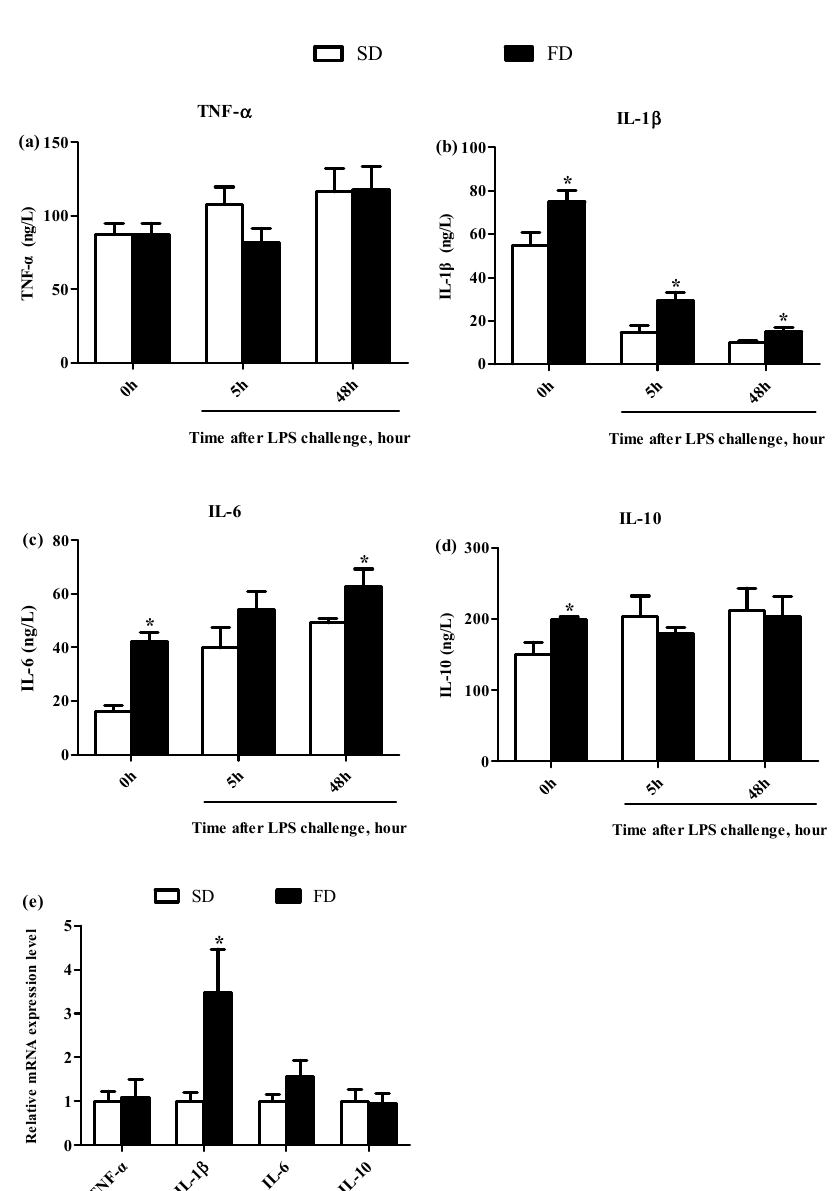
Figure 2. E ff ect of maternal diet with fish oil on the concentrations of cytokines in plasma and mRNA expression of cytokines in the livers of piglets. TNF- α concentration ( a ), IL-1 β concentration ( b ), IL-6 concentration ( c ) and IL-10 concentration ( d ) in plasma collected from piglets on 14 d (14 d), 14 + 5 h after LPS challenge (5 h), and 14 + 48 h after LPS challenge (48 h) were determined. Relative expression levels of IL-1 β , IL-6, TNF- α , and IL-10 mRNA in livers of piglets collected after 48 h treatment of LPS collected from sows fed di ff erent diets ( e ) were determined by real-time PCR method. Values from plasma are means ( n = 6), and values from livers are means ( n = 4), with their standard errors represented by vertical bars. * Mean values were significantly di ff erent between the two diet groups ( p < 0.05). SD = soybean oil diet, FD = fish oil diet.